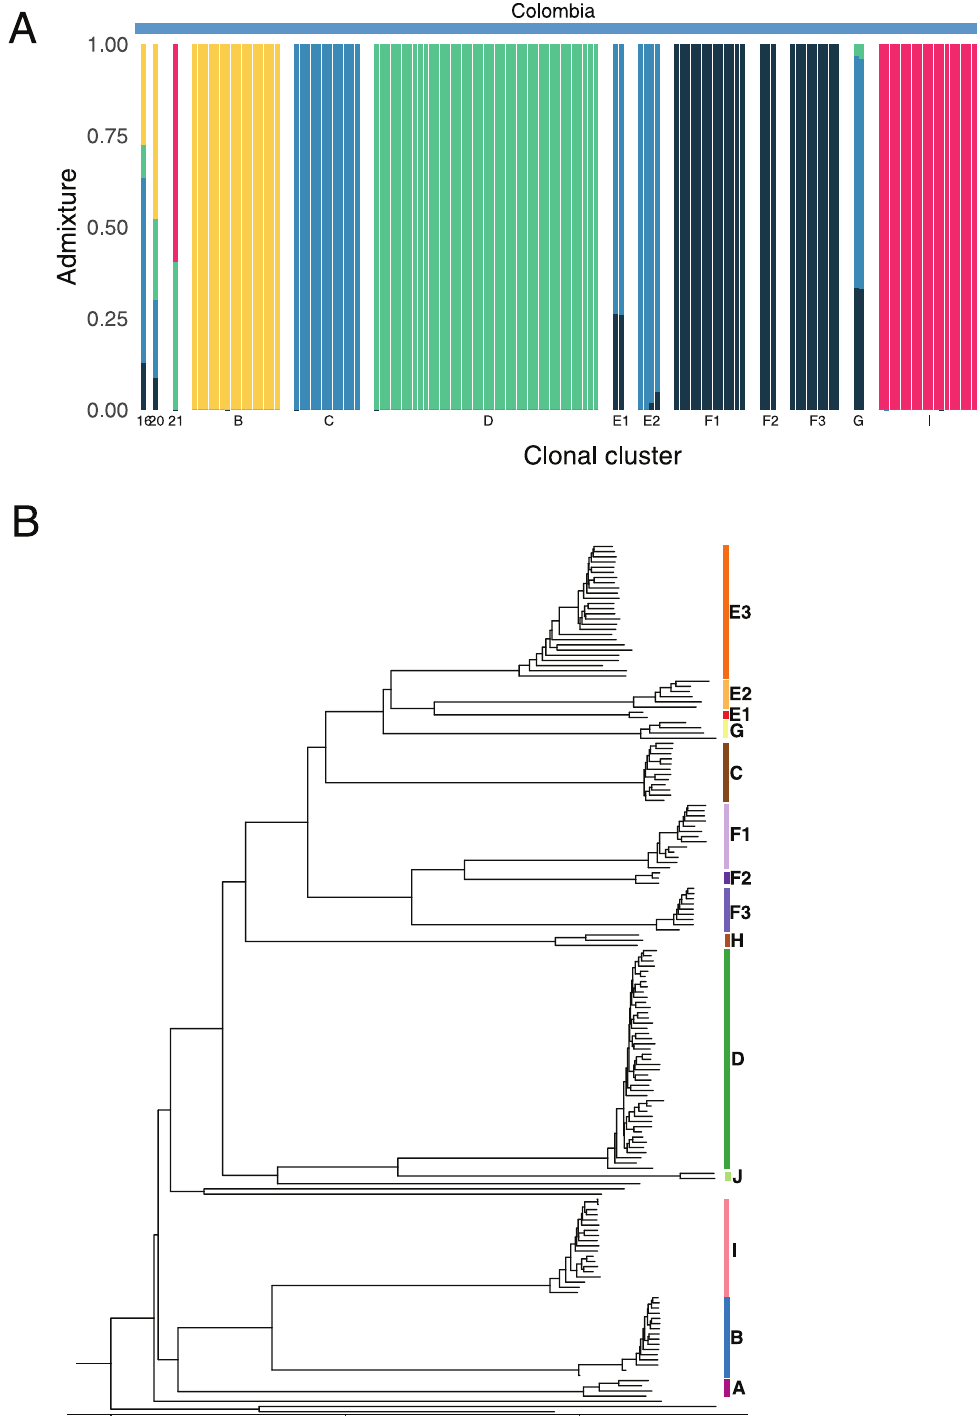
Fig 3. Comparison of an IBD approach to genetic distance analysis and visualization methods. (A) ADMIXTURE analysis of the 2014–2017 Colombia- Venezuela samples identifies five major groups, which correspond with the four largest clonal clusters (B, C, D, and I) and one highly related supercluster (F1-F2-F3) in the IBD analysis. In addition to being less granular, these results are dependent on cluster frequency (S4 Fig) and their interpretation is less straightforward than relatedness analysis. (B) Depicting cluster relationships with a neighbor-joining tree based on genetic distance shows more fine-scaled inter-cluster relationships than ADMIXTURE, however, these are qualitative whereas the IBD heat map in Fig 2C provides quantitative relatedness estimates.